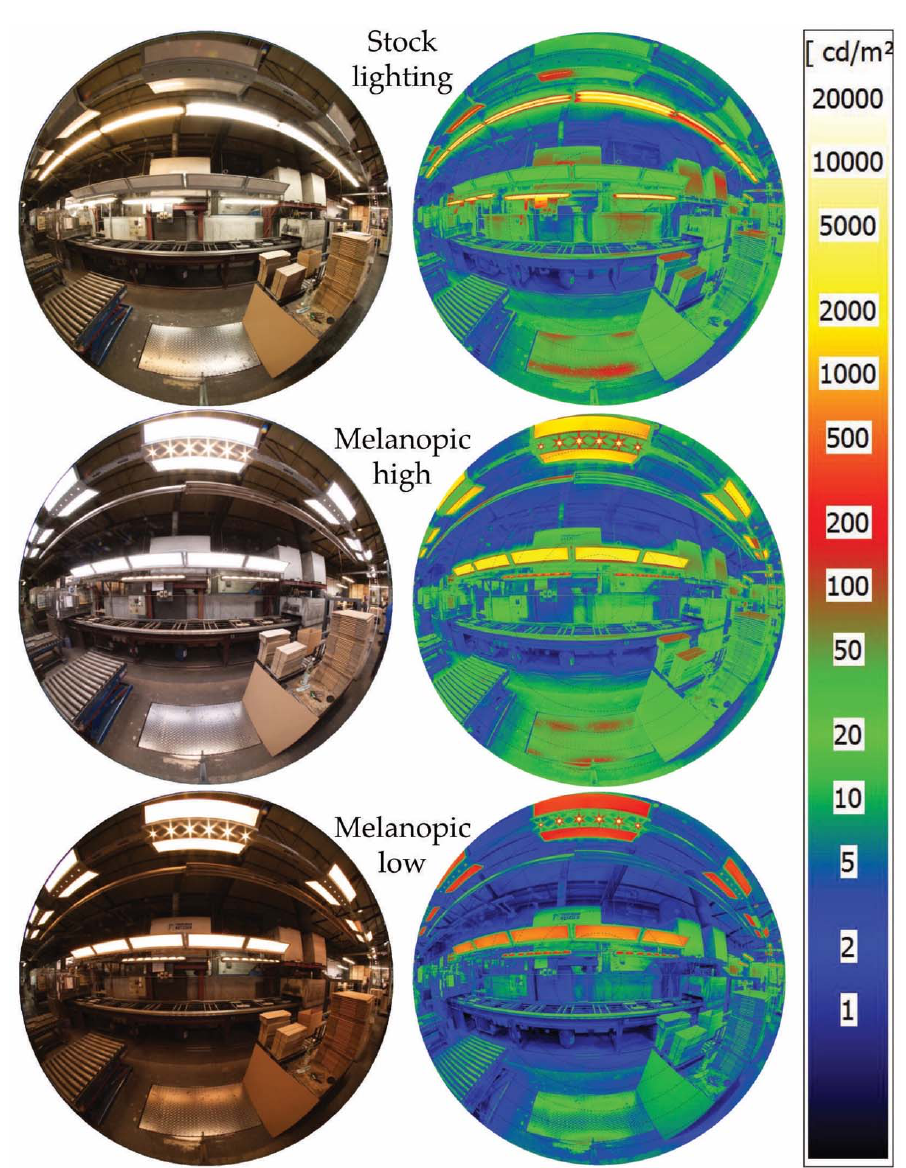
Figure 7. Luminance distribution between the old ( top panels ) and the new lighting systems for high ( middle panels ) and low ( bottom panels ) melanopic settings. The right panels show false-color luminance pictures according to the scale with a 180° fisheye camera. The left panels show the corresponding photographs.